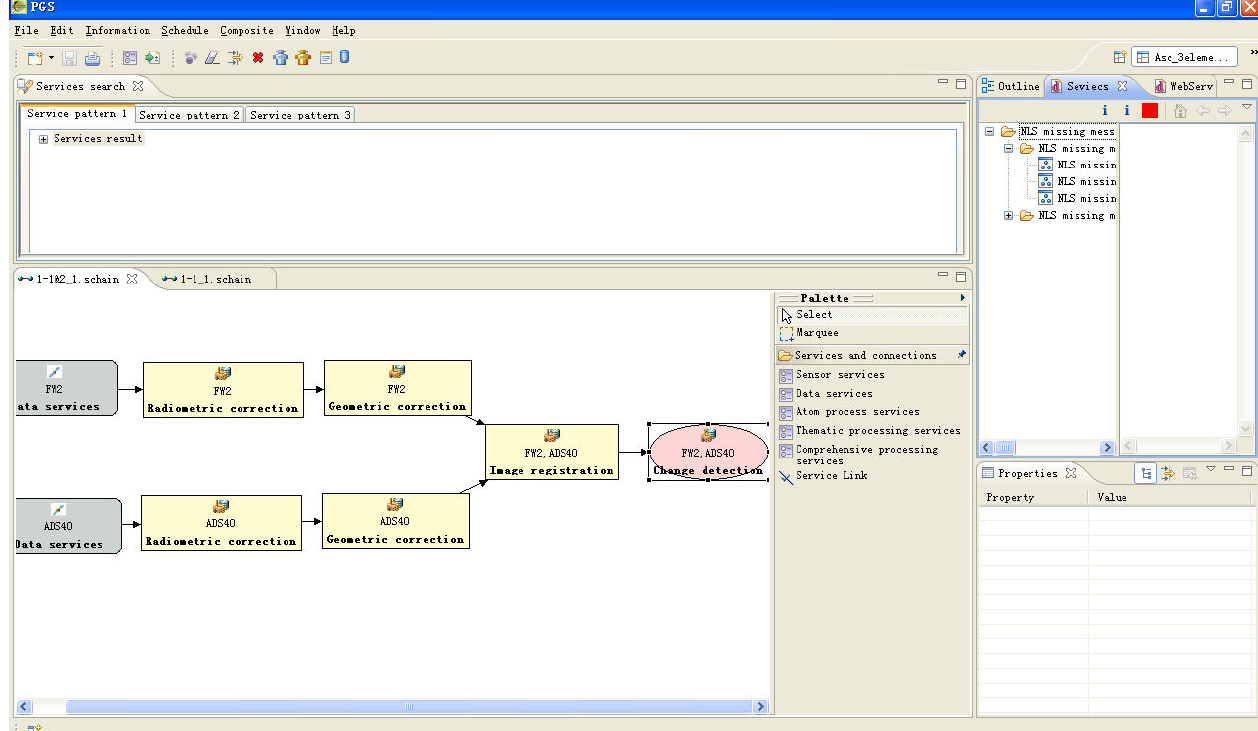
Figure 15. The resulting GISC after the automatic service